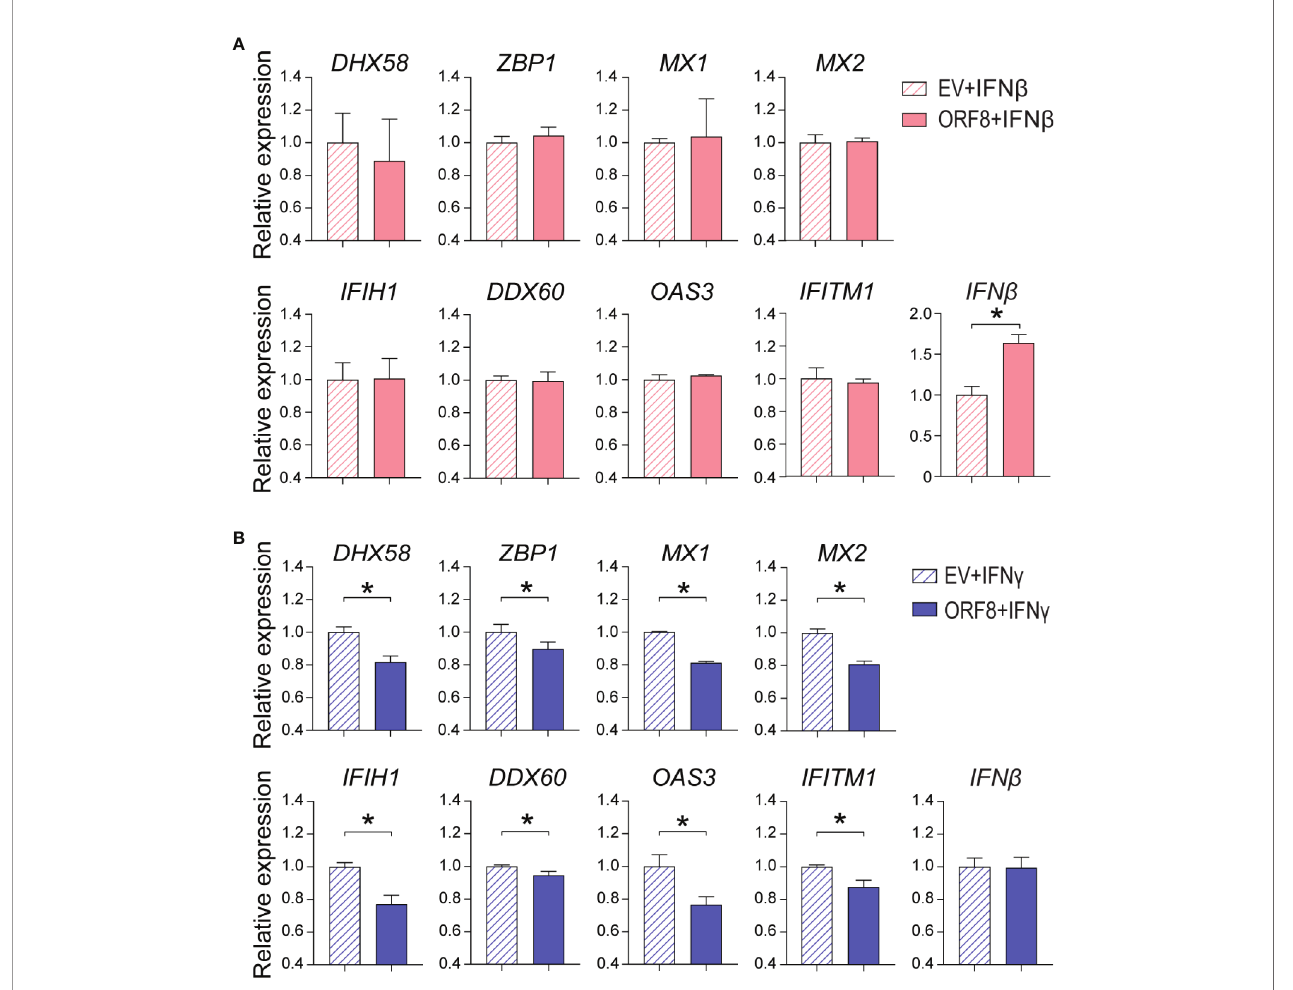
FIGURE 5 | Characterization of the role of ORF8 SARS-CoV-2 on regulation of type I and II interferon (IFN)-induced expression of antiviral molecules in human lung epithelial cells. Human A549 lung epithelial cells were transfected with pEGFP-N1 (empty vector, EV) or pEGFP-ORF8 SARS-CoV-2 . The transfected cells were treated with medium containing IFN b (100 ng/mL) (A) or IFN g (100 ng/mL) (B) for 24 h followed by RNA extraction and RT-qPCR analysis of expression of the indicated genes. n = 3-5. * p < 0.05 was considered as statistically signi fi